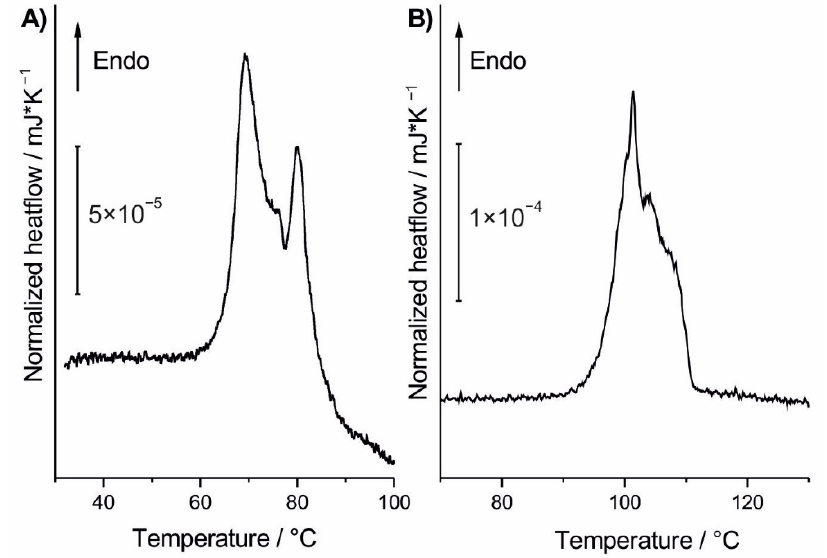
Figure 6. Heating scans of compound 4 ( A ) and compound 5 ( B ) in powder form without premelting. 100 K/s heating rate.